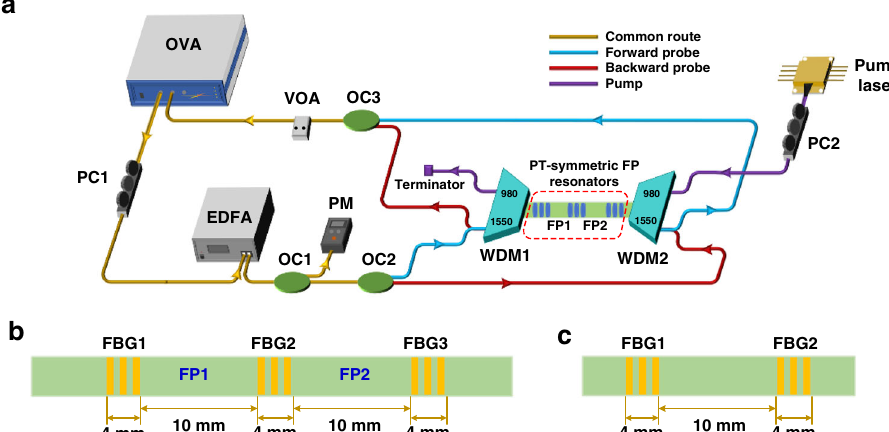
Fig. 2 Experimental setup. a Schematic of the experimental setup for forward and backward transmission measurements. Optical paths for forward and backward transmission are shown by the blue and red lines, respectively. The shared optical paths for both forward and backward transmission are shown by the yellow lines. The optical path for the pump light is shown by the purple line. b A fabricated all- fi ber nonreciprocal device based on parity-time- symmetric FP resonators. c A fabricated single FP resonator on an EYDF to characterize the gain-saturation nonlinearity in the FP resonator. OVA: optical vector analyzer; VOA: variable optical attenuator; PC: polarization controller; EDFA: erbium-doped fi ber ampli fi er; OC: optical coupler; PM: power